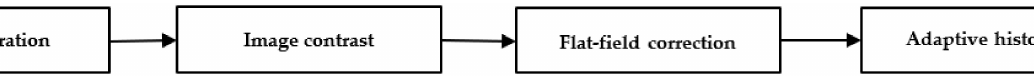
Figure 2. Flow chart of the image